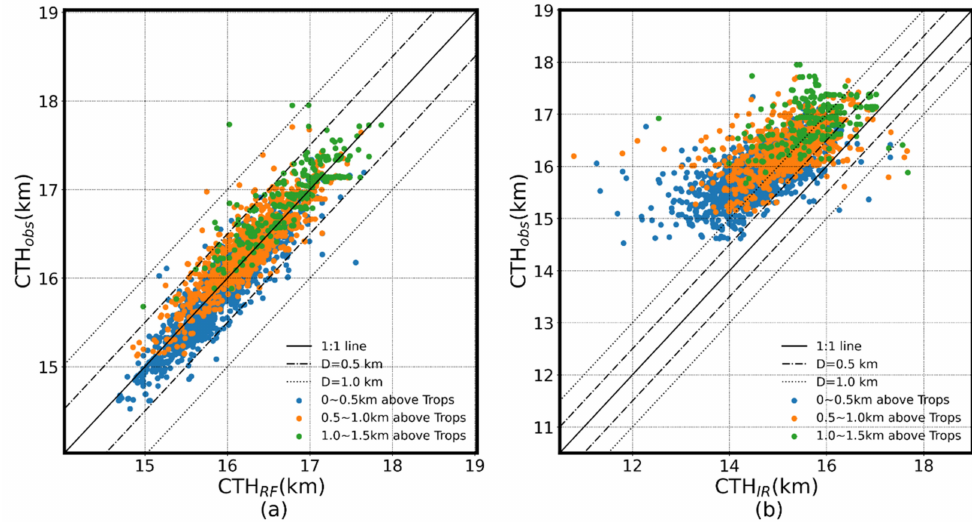
Figure 6. ( a ) Comparison of CTH from RF model and CloudSat; ( b ) comparison of CTH from the traditional single-channel interpolation method and CloudSat. Green, orange, and blue dots represent overshooting cloud-top height with overshooting depths of 0–500 m, 500–1 km, and above 1 km separately. The black dashed line represents the 1:1 line while the dash and the dotted line represent the residual between calculated and observed CTH of 500 m and 1 km,